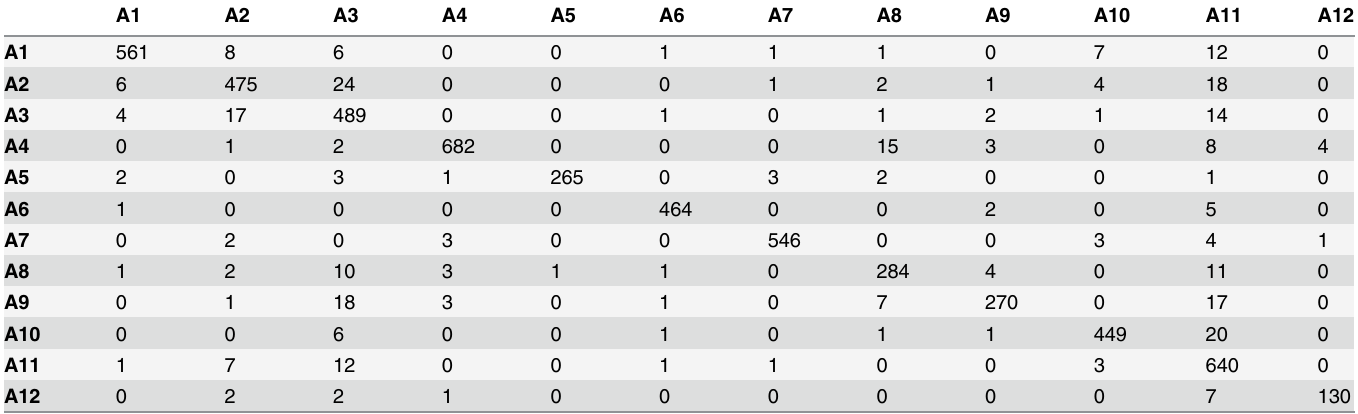
Table 3. Confusion matrix for rotation forest classifier (Acceleration sensor placed at